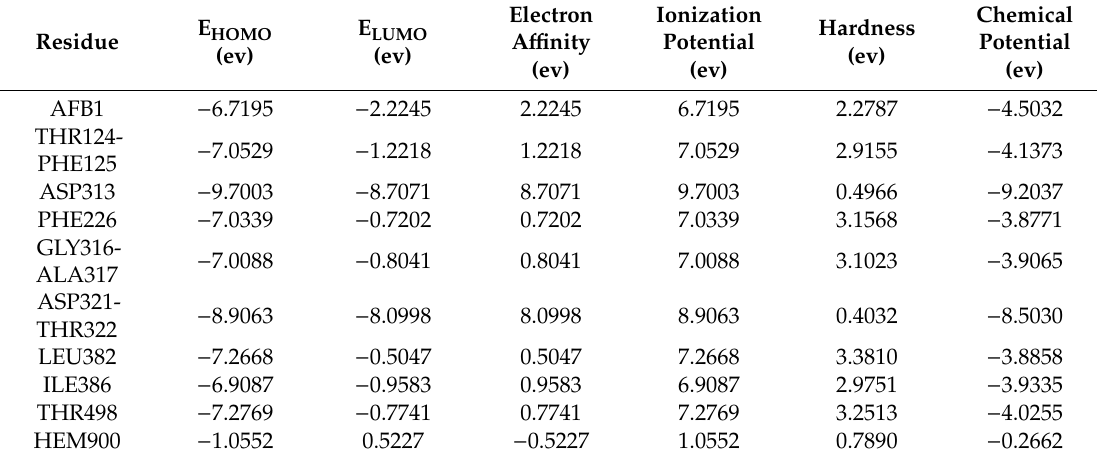
Table 7. Chemical reactivity parameters of amino acids present in the active site of CYP1A2 (2HI4 PDB ID) provided by the interaction with aflatoxin AFB1.